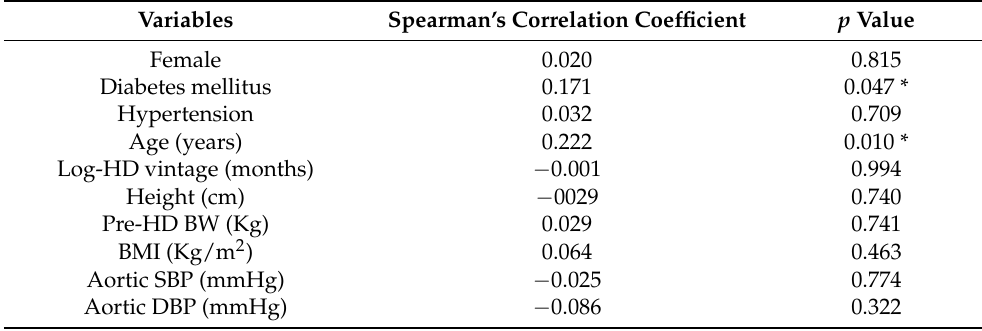
Table 4. Correction between log-transformed soluble urokinase-type plasminogen activator